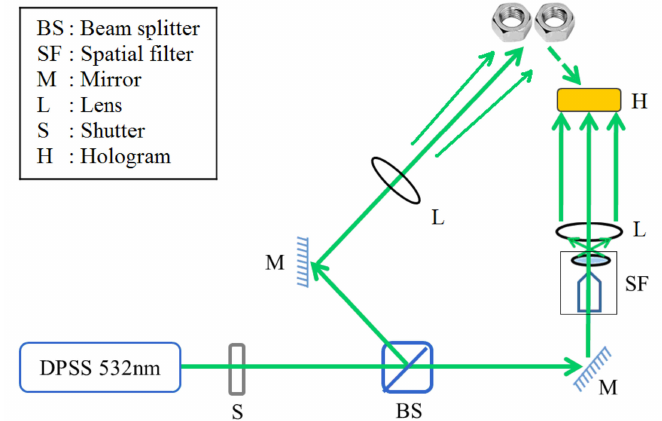
Holographic inscription setup for recording and reconstructing the image of